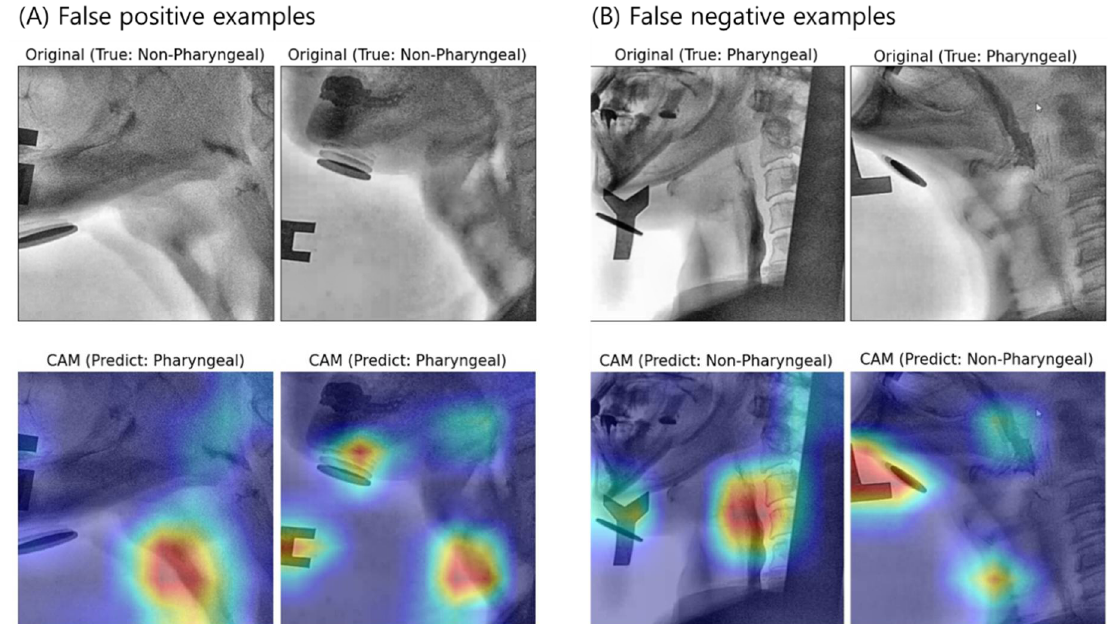
Figure 10. Sample images of original and Grad-CAM presumed to be falsely positively predicted ( A ) and falsely negatively predicted ( B ) by the best performing classification model (VGG16-FT5).